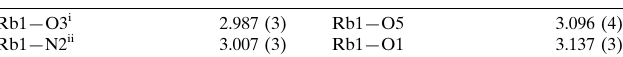
Selected geometric parameters (A˚ , (cid:2) ).